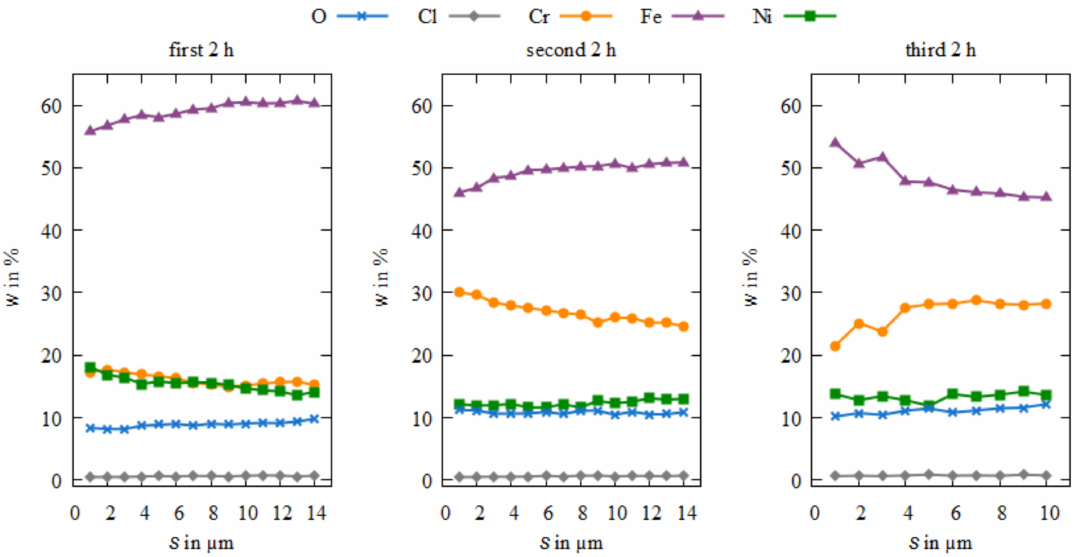
Figure 12. EDXS measurement of alloy compositions over the entire layer thickness of the stepped DC t on = 5 s, t off = 2 s samples depending on the electrolyte